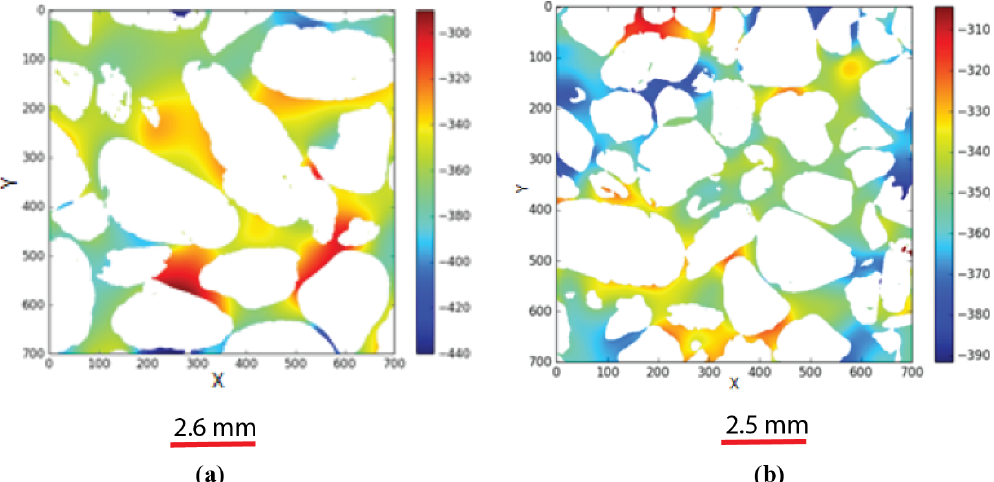
Figure 8. Electrical potential field image output from the 700 3 digital sub-cubes of (a) Scarborough (b) Cottesloe beaches. The colour bar indicates regions of high (red) and low (blue) potential field in arbitrary units.